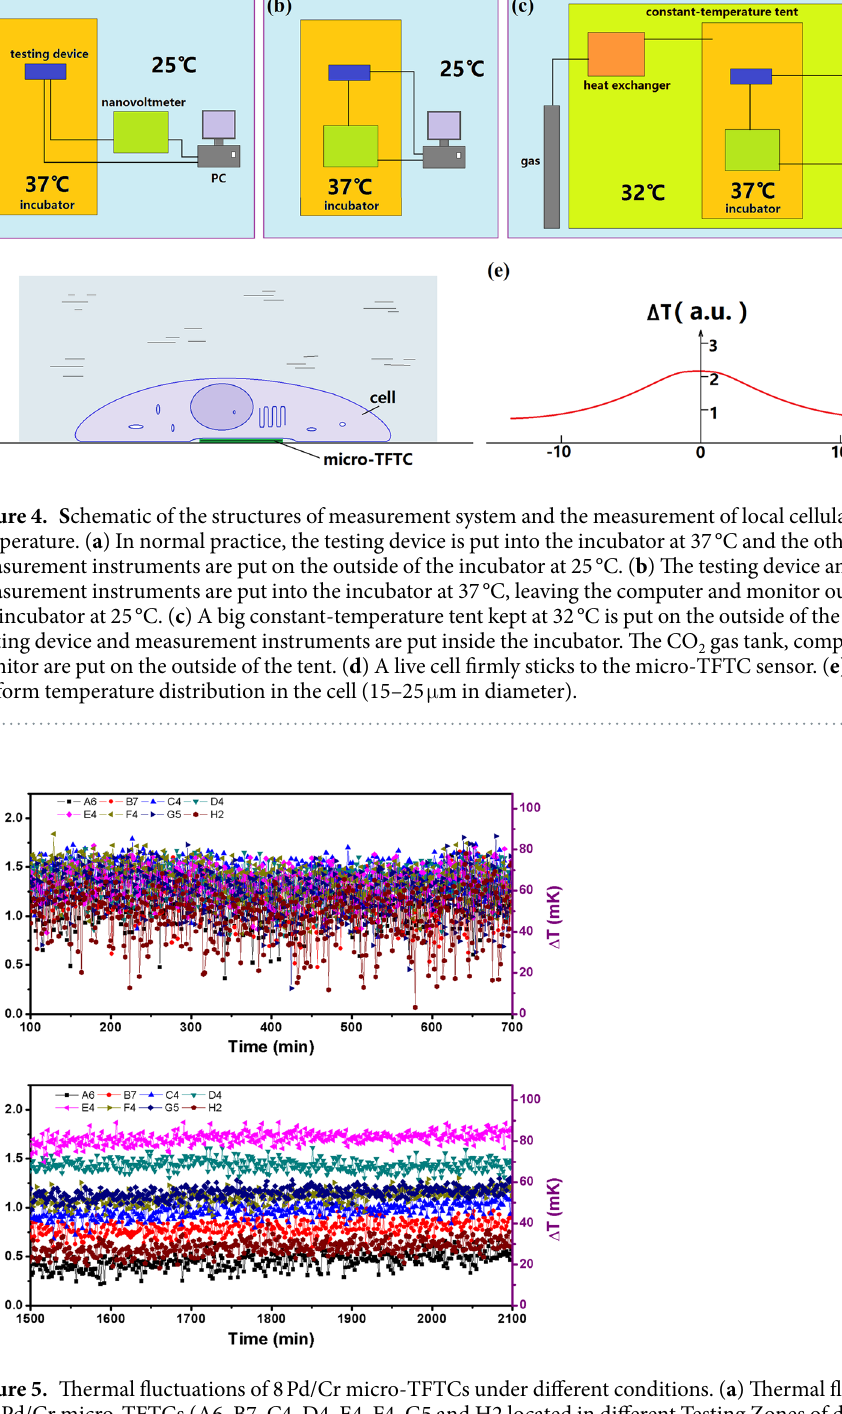
Figure 5. Thermal fluctuations of 8 Pd/Cr micro-TFTCs under different conditions. ( a ) Thermal fluctuations of 8 Pd/Cr micro-TFTCs (A6, B7, C4, D4, E4, F4, G5 and H2 located in different Testing Zones of different regions) tested in an ordinary laboratory kept at 25 °C, which were exposed to the air. ( b ) Thermal fluctuations of the same TFTCs tested in the double-stabilized constant-temperature system kept at 32 °C, which were covered by culture